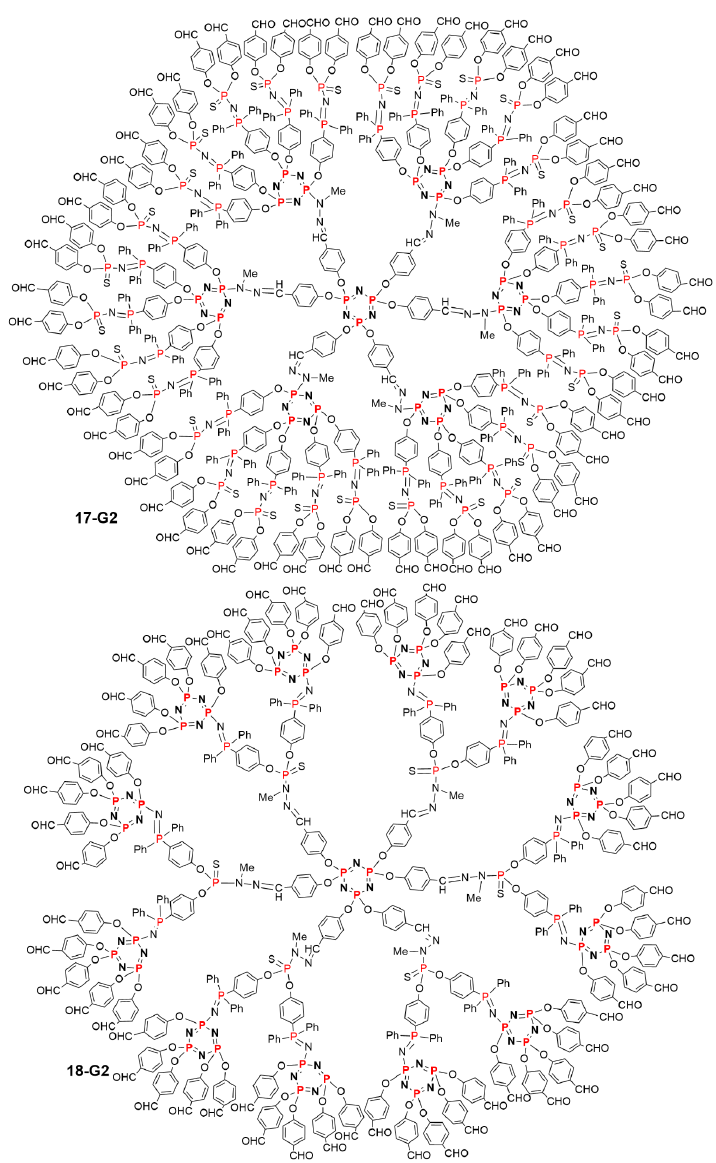
Figure 11. Comparison between the full structure of the second-generation dendrimers 17-G2 and 18-G2 .